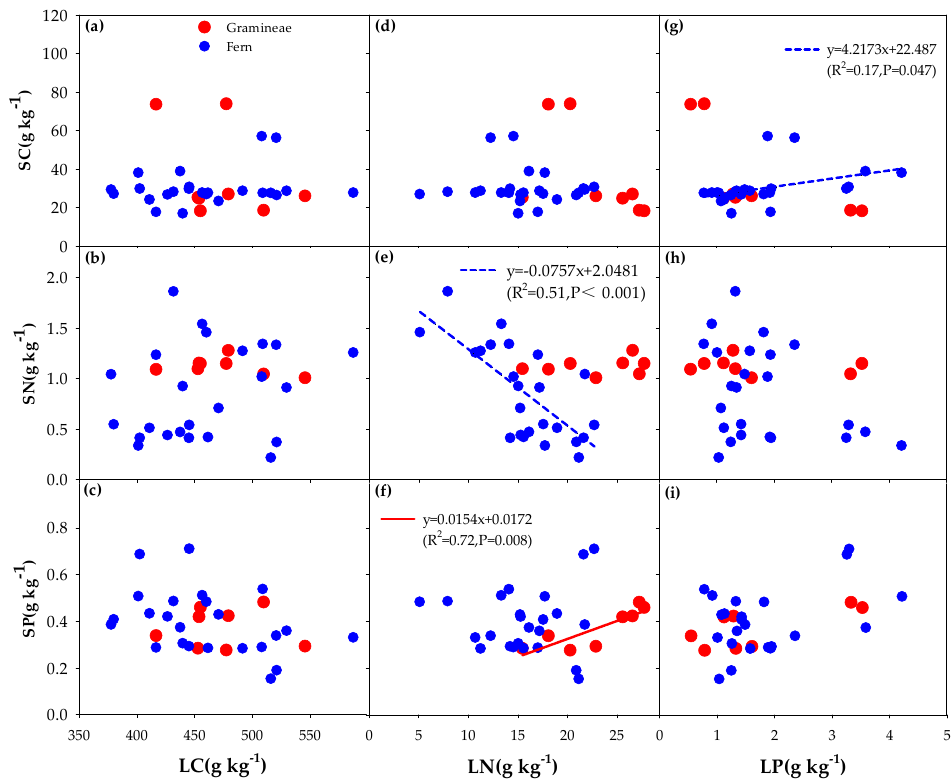
Figure A3. Correlations between litter and soil C, N and P of four dominate species with two different functional types (Gramineae Lophatherum gracile and fern Woodwardia japonica , Dryopteris atrata and Dicranopteris dichotoma ) in P addition treatment.